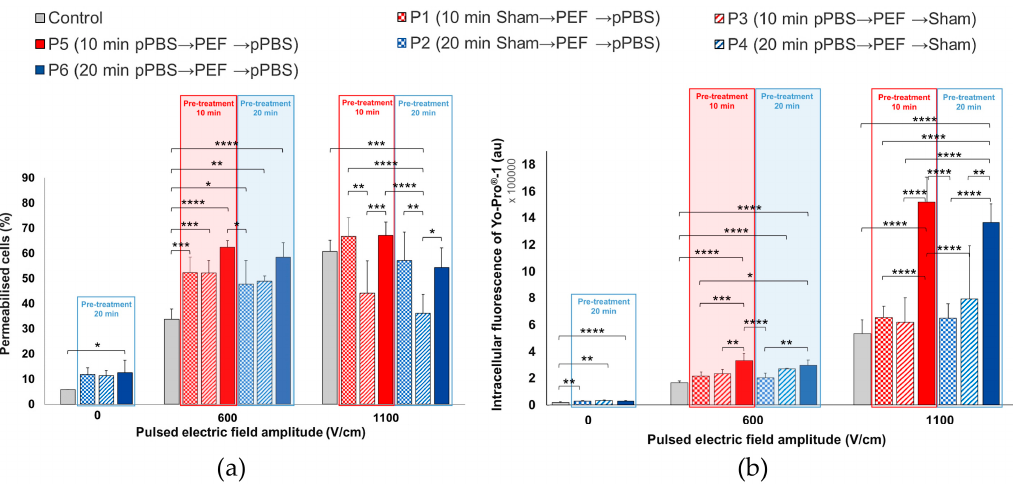
Figure 6. Effects of the combined treatment on malignant B16-F10 melanoma cells using µsPEF at 0, 600, and 1100 V/cm. ( a ) Percentage of electropermeabilised cells and ( b ) intracellular fluorescence of YO-PRO ® -1 iodide entering the cells as a function of the seven combined protocols applied. Data are presented as mean (for a ) and median (for b ) values ± SD of independent triplicates. Statistical differences were analysed while using One-way ANOVA followed by Bonferroni’s multiple comparison test. * p < 0.05, ** p < 0.01, *** p < 0.001, and **** p < 0.0001 significant differences.